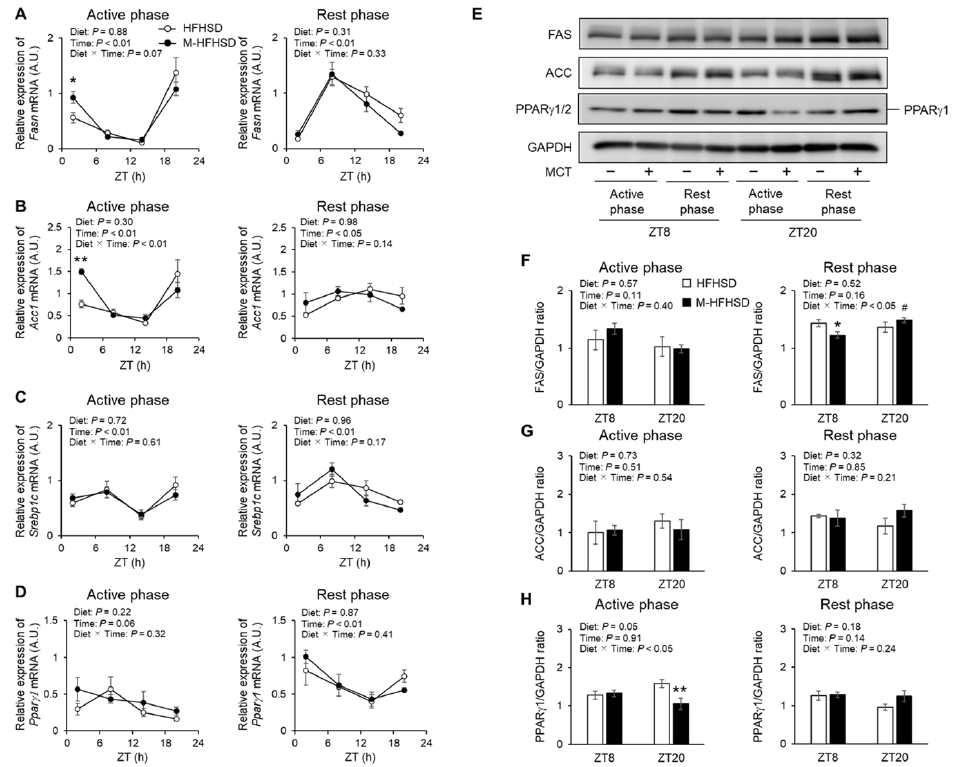
Figure 5. Expression of lipogenic genes and proteins in the liver. Expression levels of Fasn ( A ), Acc1 ( B ), Srebp1c ( C ), and Pparg1 ( D ) mRNA at indicated times in the liver of mice. ( E ) Protein expression levels of FAS, ACC, PPAR γ 1 and GAPDH in liver extracts from mice. ( F – H ) Ratios of FAS-, ACC-, and PPAR γ 1-to-GAPDH. Data are mean ± SEM ( n = 4). * p < 0.05 and ** p < 0.01 vs. HFHSD at same time. # p < 0.05 vs. same diet at ZT8. HFHSD, high-fat high-sucrose diet; MCT, medium-chain triglyceride; M-HFHSD, high-fat high-sucrose diet containing medium-chain triglyceride; ZT, zeitgeber time.